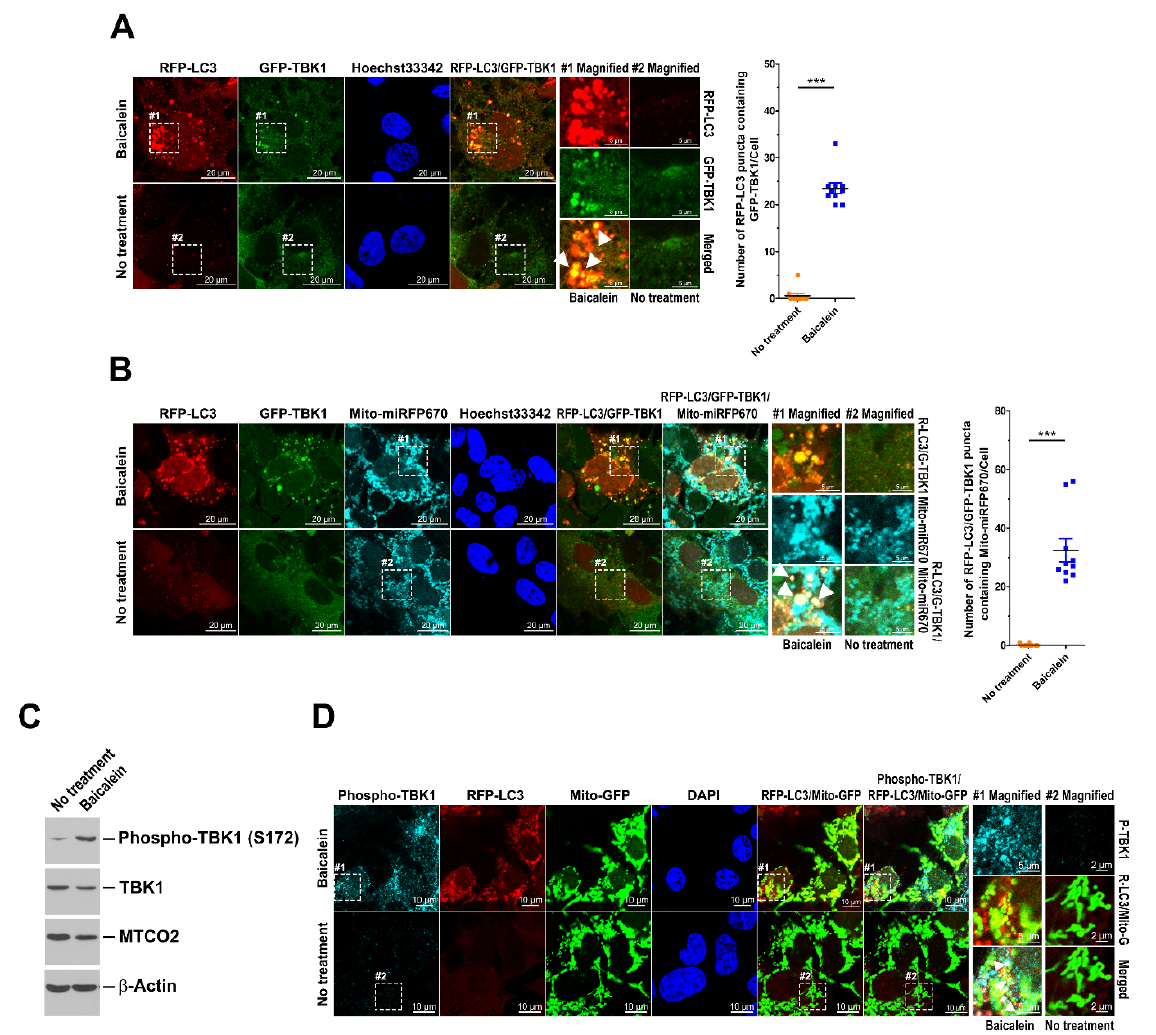
Figure 9. Activation of TBK1 in baicalein-induced mitophagy: ( A ) Huh7 cells stably coexpressing RFP-LC3 and GFP-TBK1 (Huh7/RFP-LC3/GFP-TBK1) were established by lentiviral gene delivery as described in “Materials and Methods”. Huh7/RFP-LC3/GFP-TBK1 cells were treated with or without 0.5 mM baicalein for four hours, fixed and stained with Hoechst 33342, and analyzed by confocal microscopy. The number of RFP-LC3 puncta colocalized with GFP-TBK1 was quantified. The data represent the means ± SEM ( n = 10, *** p < 0.001). Magnified field-1 and magnified field-2, respectively, show the enlarged images of the areas in white dashed boxes 1 and 2 in the images of baicalein-treated and untreated cells. The white arrowheads in the magnified field-1 indicate the overlapping signal. ( B ) Lentiviruses harboring RFP-LC3, GFP-TBK1, and Mito-miRFP670 were transduced into Huh7 cells, generating Huh7/RFP-LC3/GFP-TBK1/Mito-miRFP670 cells. Huh7/RFP-LC3/GFP-TBK1/Mito-miRFP670 cells were cultured in the presence or absence of 0.5 mM baicalein. Four hours later, the cells were fixed, stained with Hoechst 33342, and analyzed by confocal microscopy. ( C ) Huh7 cells were treated with or without 0.5 mM baicalein for eight hours and harvested for protein expression analysis by Western blotting. ( D ) Baicalein-treated Huh7/RFP-LC3/Mito-GFP cells were fixed, immunostained for phospho-TBK1 (Ser172) and nuclei by DAPI, and analyzed by confocal